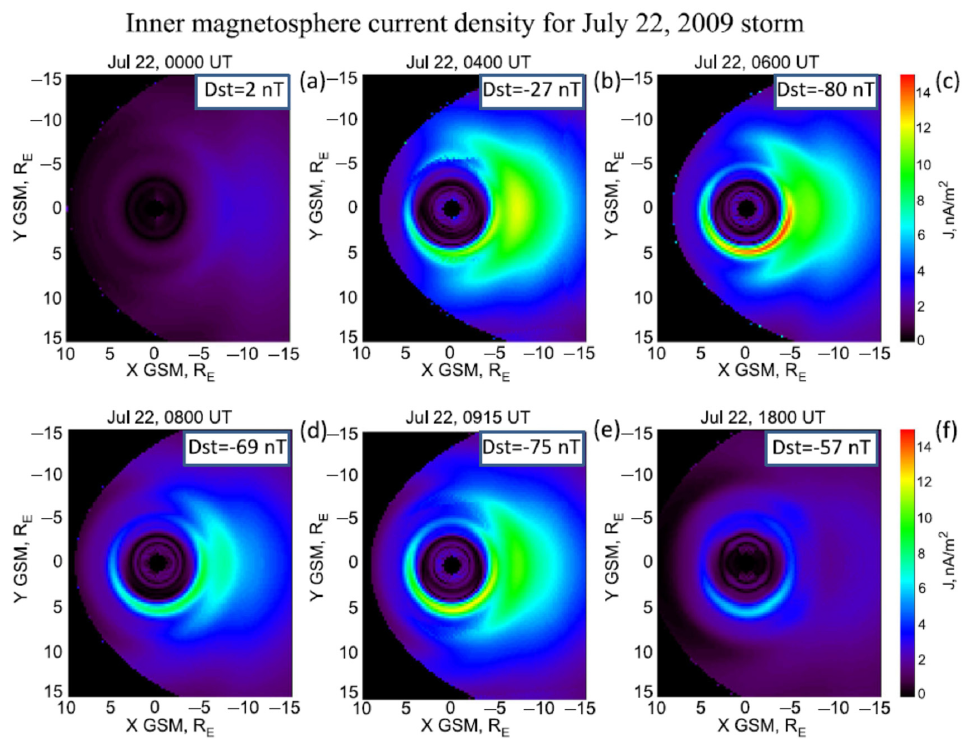
Figure 9. Evolution of the inner magnetosphere current density in the equatorial plane computed from the curl of the magnetic field modelled with the Tsyganenko T02 global magnetospheric magnetic field model during the storm event on 22 July 2009. ( a ) A relatively symmetric ring ( b ) the ring current intensifies with the development of the storm. ( c ) the asymmetric ring current, with its peak shifted duskward. ( d ) During the recovery phase of the storm the ring current density decreases, ( e ) but remains asymmetric. When Dst decreases intensified ring current is seen. ( f ) with Dst = − 57 nT, the ring current density decreases, and distribution shifts toward symmetry, although it is not fully symmetric.